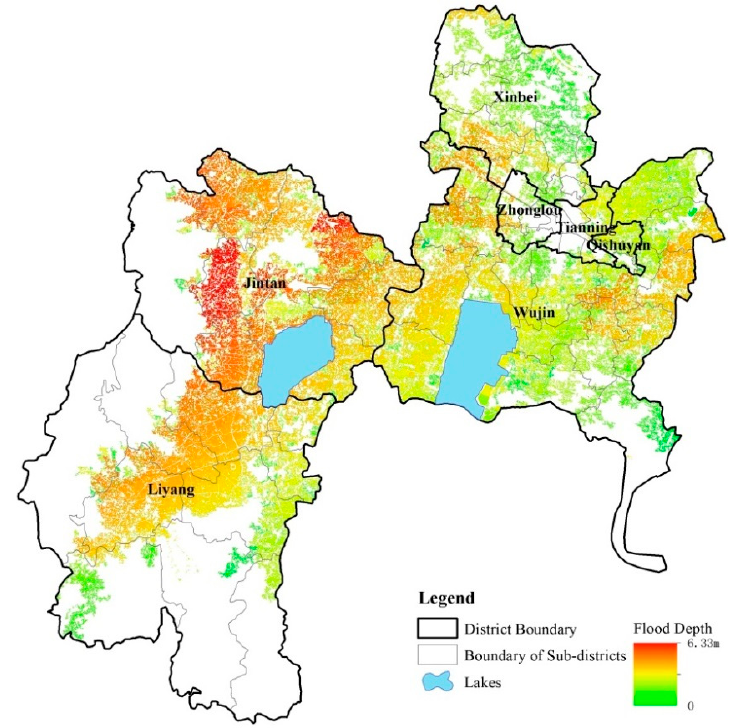
Figure 6. Flood inundation map. Table 3. Detection results of the three methods.